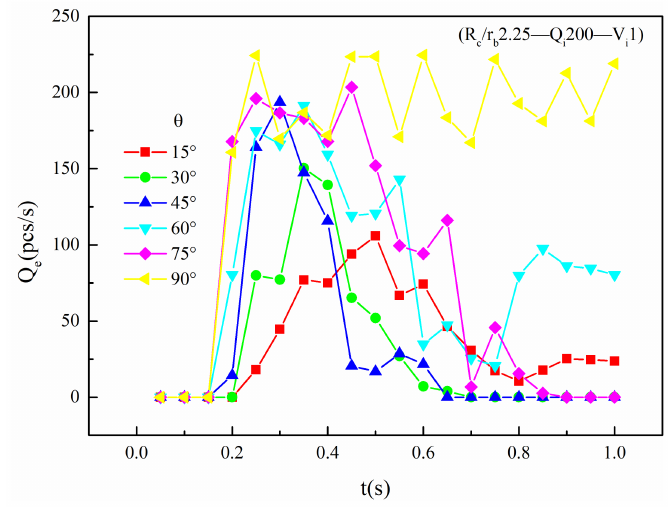
Figure 14. The relationship between the Q e and the time at different dip angles.